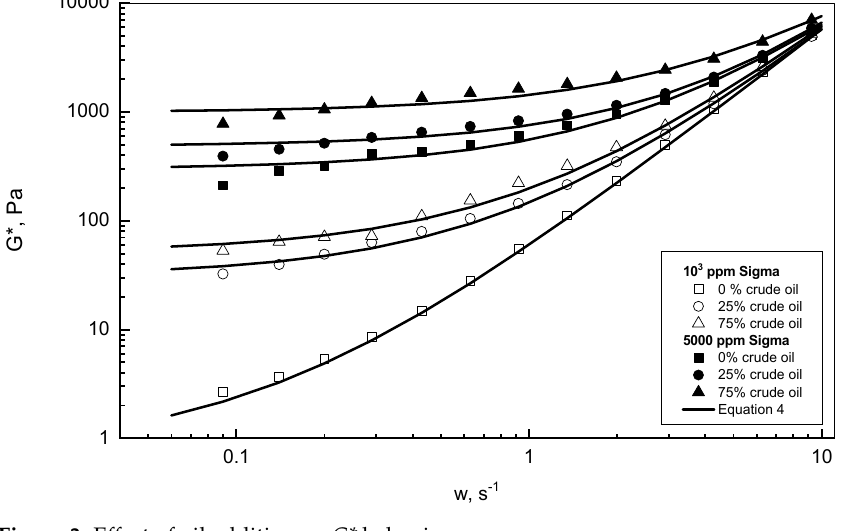
Figure 3. Effect of oil addition on G* behavior.